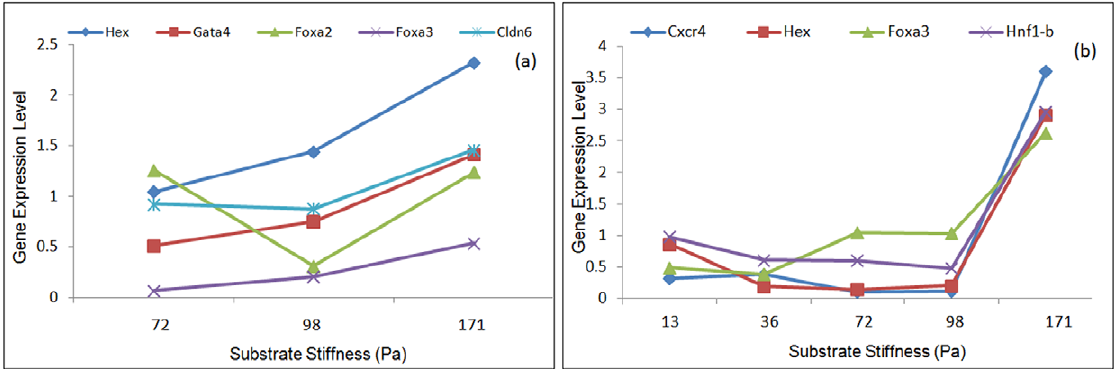
Figure 7. Identified robust bi-clusters. Robust bi-cluster for 2-dimensional culture (a) and 3-dimensional culture (b). Bootstrap re-sampling of the experimental data set, followed by biclustering at the bootstrap point leads to the identification of the robust bi-cluster. These bi-clusters are insensitive to experimental noise and appear with high frequency in the bootstrap analysis. Note that the robust bi-cluster is different from that identified at the